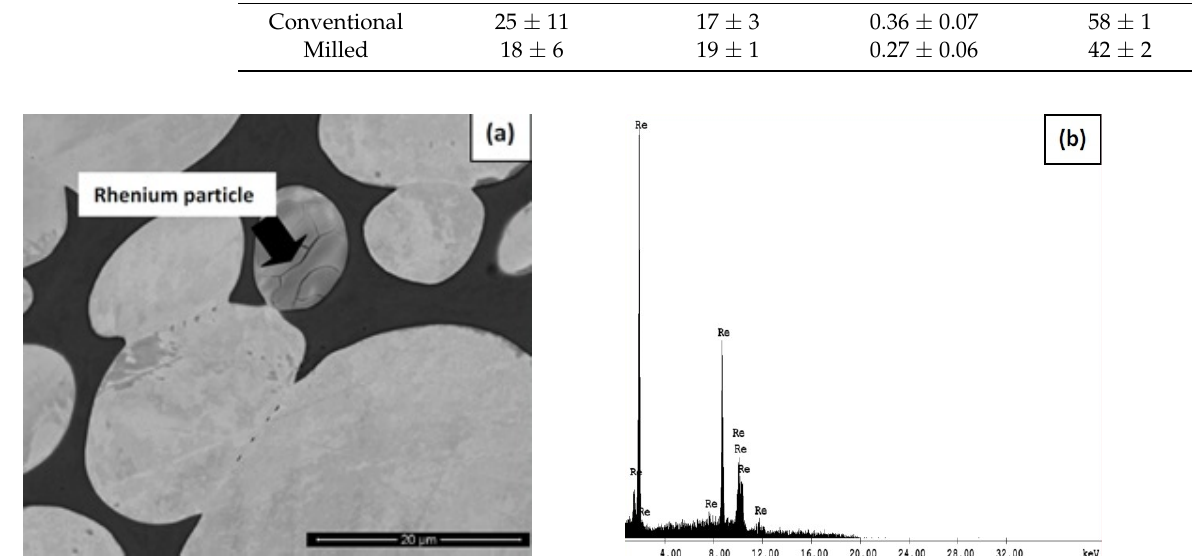
Figure 2. ( a ) SEM micrograph showing the presence of undissolved rhenium particles in the conventionally sintered alloy without milling and ( b ) Energy-Dispersive Spectroscopy pattern of rhenium (Re) particle [51]. Reproduced with permission from Ravi Kiran et al., Journal of Alloys and Compounds; published by Elsevier, 2017